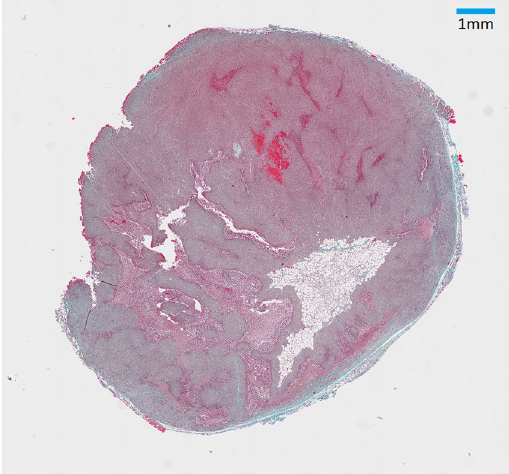
Figure 8. Histological example of Masson’s trichrome. The green-like collagen fibres are discernible, especially close to the periphery, but their extent is small and poor contrast prevents reliable automatic